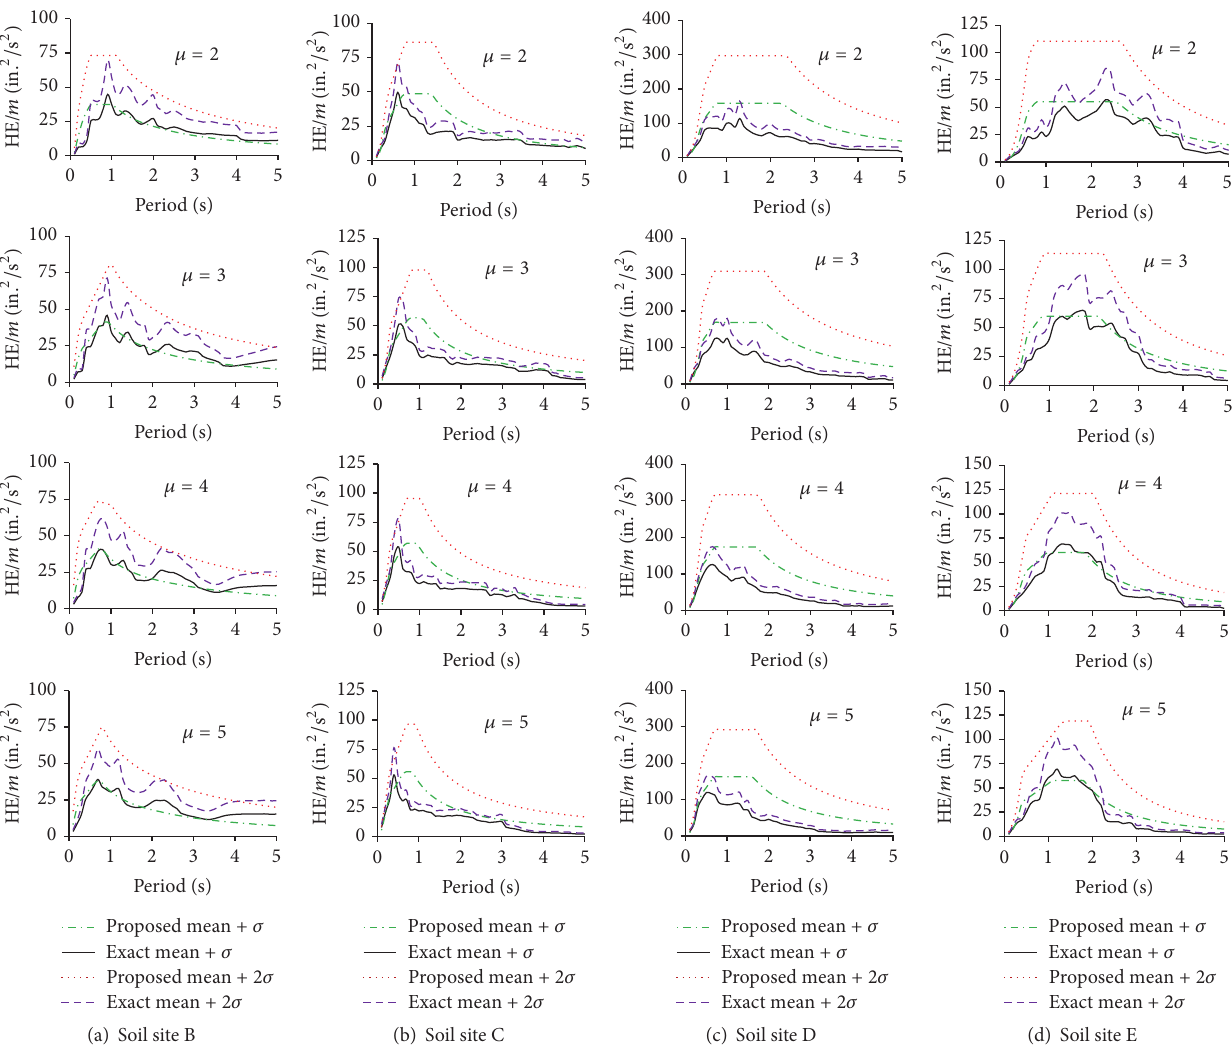
Figure 16: Comparative study of proposed hysteretic energy spectra: hysteresis model